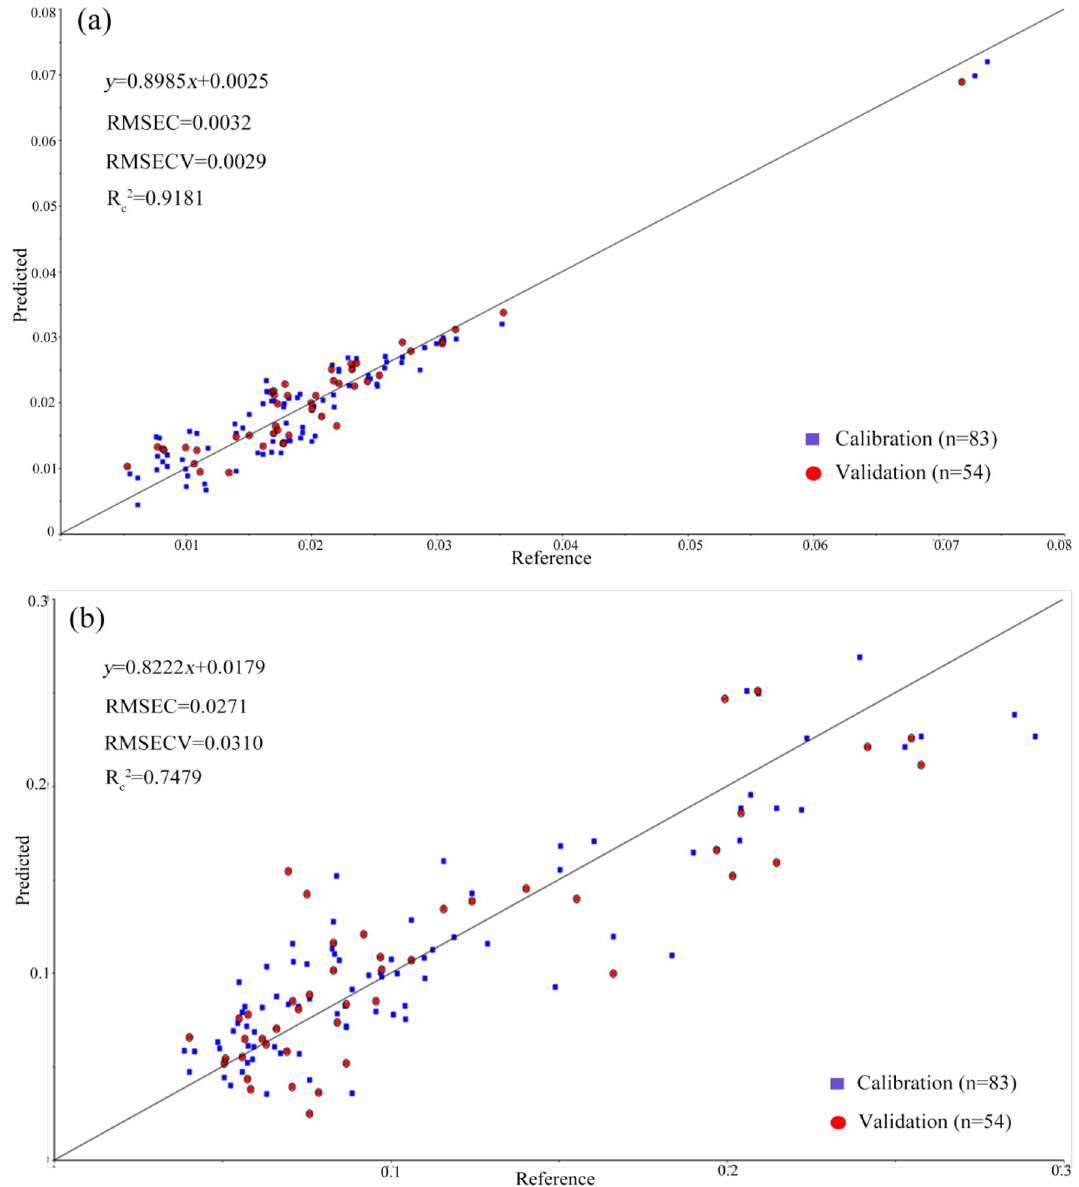
Figure 4. PLSR prediction model for Cd ( a ) and Se ( b ). “RMSEC”:root mean square error of calibration; “RMSECV”:root mean square error of cross